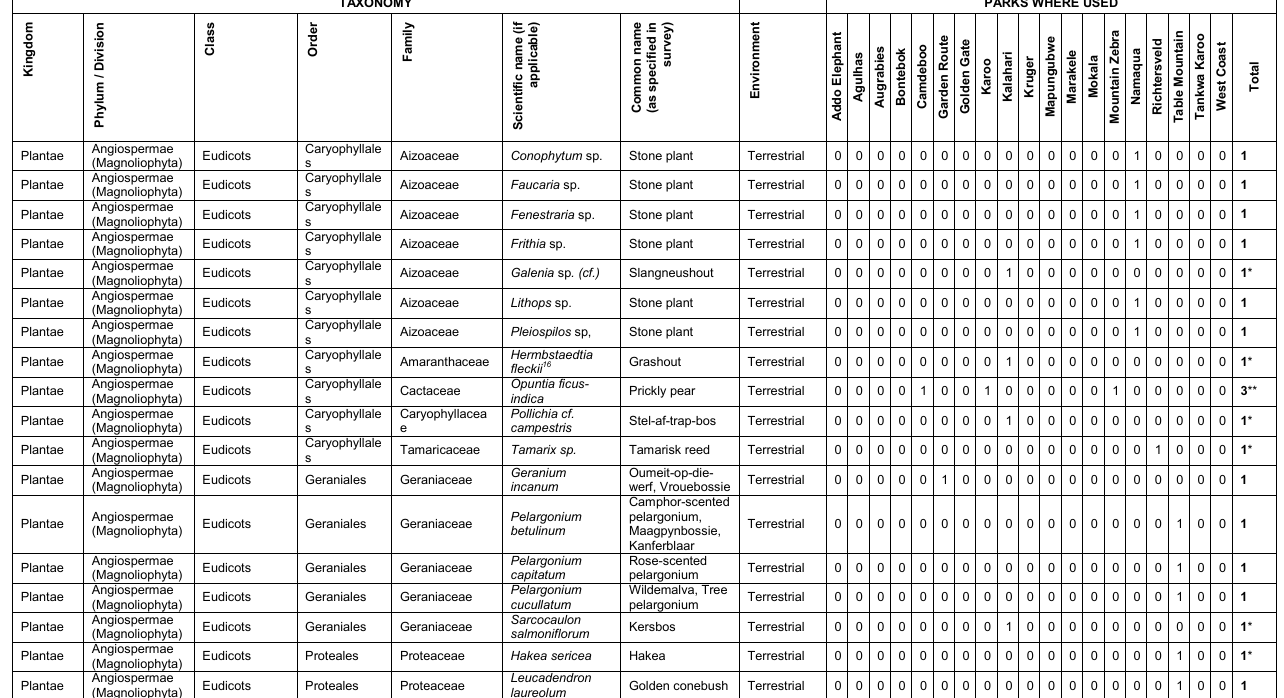
16 According to Hugo Bezuidenhout